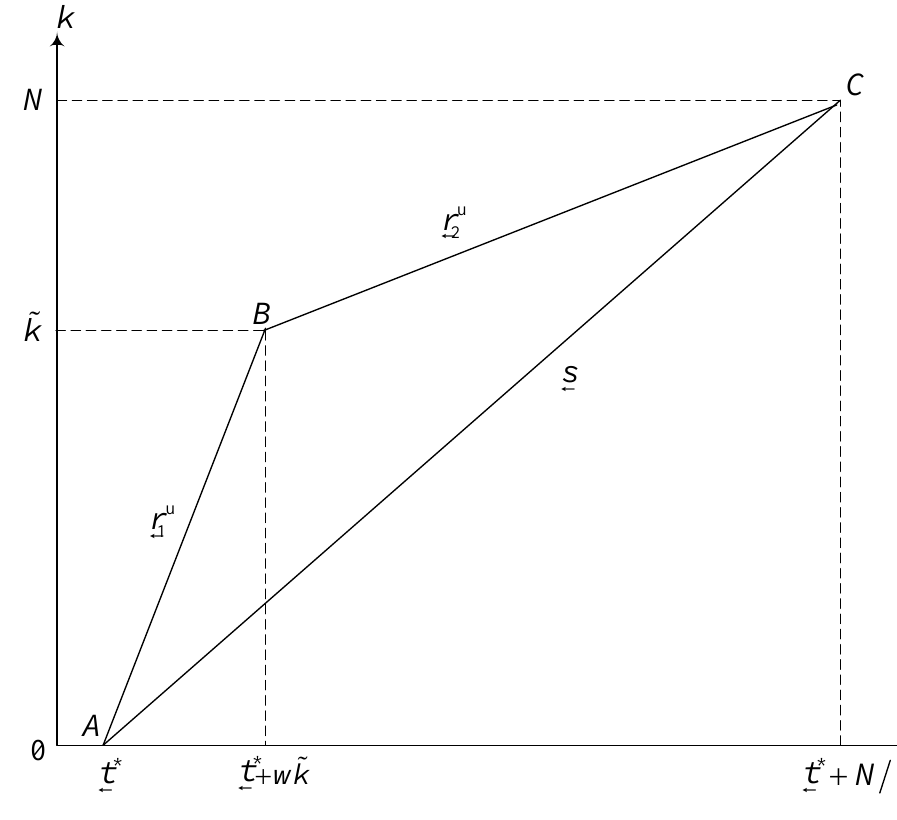
Figure 2. Traffic pattern in the evening commute, regime